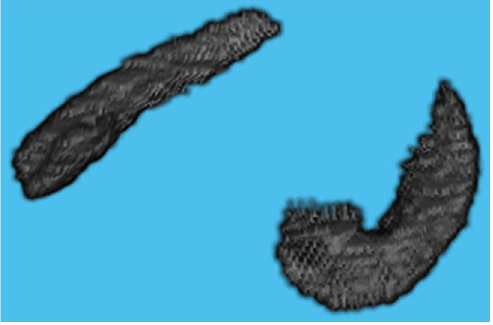
Figure 4. Segmented Hippocampus volume viewed in MATLAB.